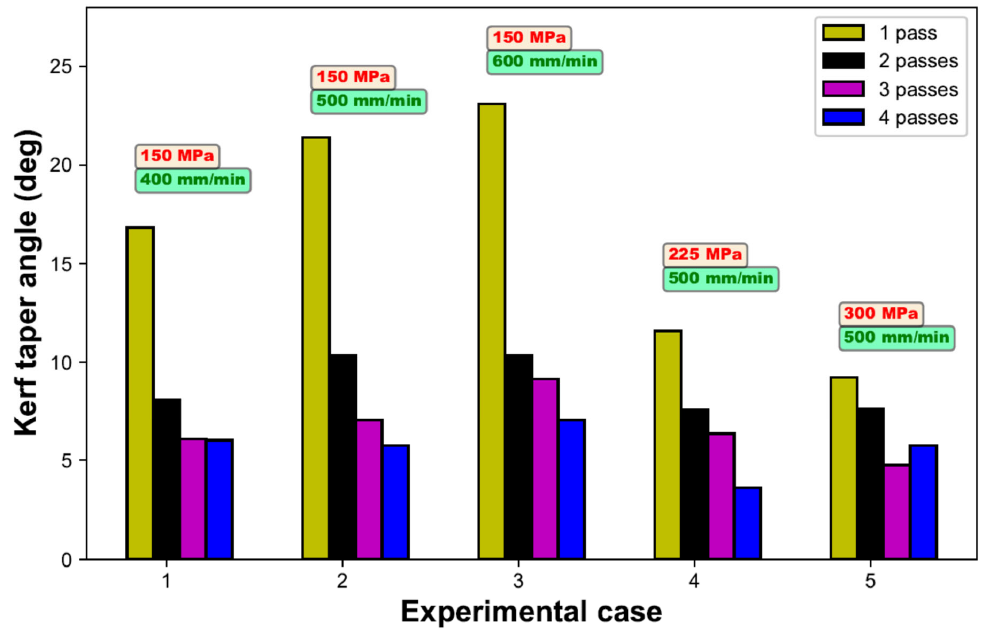
Figure 7. Variation of the kerf taper angle for an increasing number of passes and different process conditions.